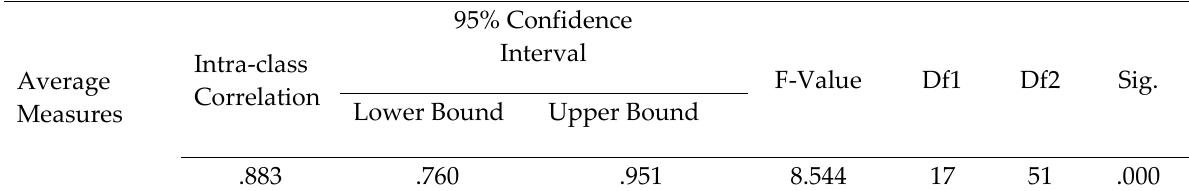
Table 1. Intra-class correlation